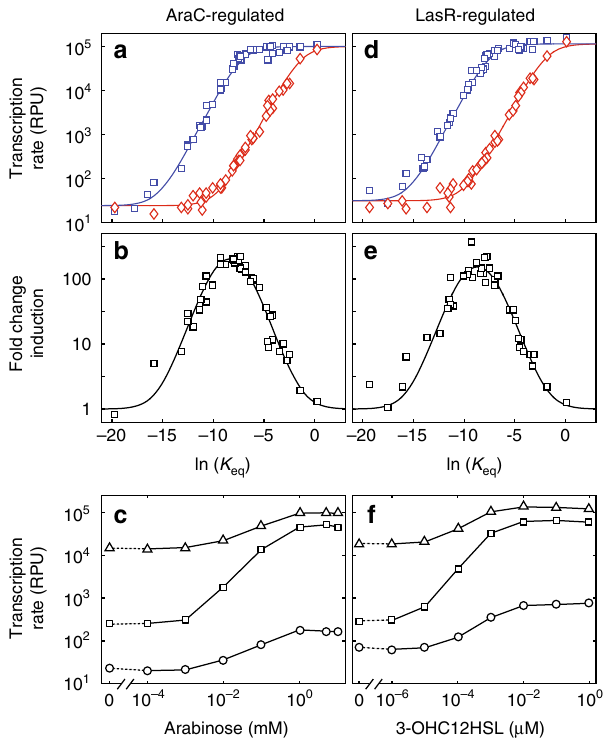
Fig. 3 A thermodynamic model of promoter af fi nity fi ts the data. a Experimentally measured transcription rates of the AraC-regulated promoter as a function of the relative equilibrium constant of σ -factor binding to the − 10 and − 35 sites for both induced (blue squares) and uninduced (red diamonds) conditions. The thermodynamic model (solid curves) was fi t to the results of each combination of the − 10 and − 35 sites. b The fold-change induction (ratio of the induced and uninduced transcription rates) of the AraC-regulated promoters as a function of relative equilibrium constant of σ -factor binding to the − 10 and − 35 sites. c Transcription rate as a function of arabinose concentration for three AraC- regulated promoters: P ara-bD (circles), P ara-dE (squares), and P ara-eG (triangles). d Experimentally measured transcription rates of the LasR- regulated promoter as a function of the relative equilibrium constant of σ - factor binding to the − 10 and − 35 sites for both induced (blue squares) and uninduced (red diamonds) conditions. The thermodynamic model (solid curves) was fi t to the results of each combination of the − 10 and − 35 sites. e The fold-change induction (ratio of the induced and uninduced transcription rates) of the LasR-regulated promoters as a function of relative equilibrium constant of σ -factor binding to the − 10 and − 35 sites. f Transcription rate as a function of 3OH-C12-HSL concentration for three LasR-regulated promoters: P las-bD (circles), P las-dE (squares), and P las-eG (triangles). Experiments were performed with biological triplicates. Error bars in each plot have been omitted for clarity as they are, in most cases, smaller than the size of the symbols. Thermodynamic modeling data and experimental data are available in Supplementary Information and